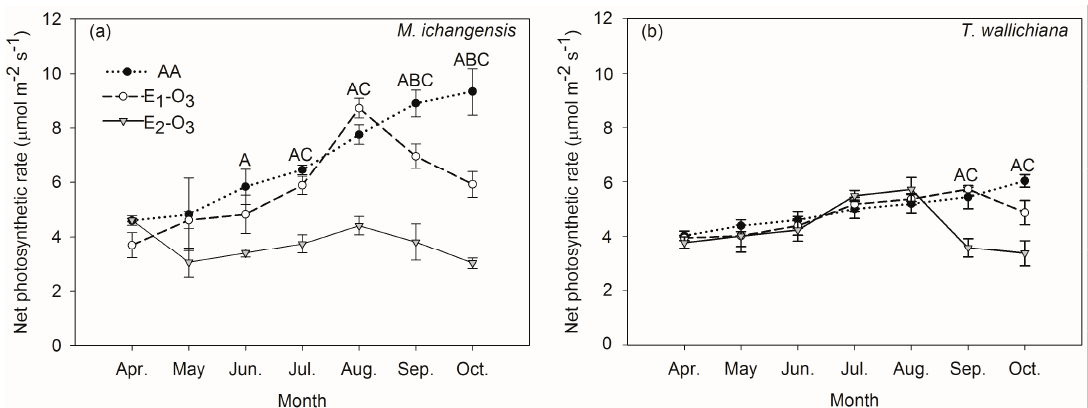
Figure 1. Variations in the net photosynthetic rate (Pn) of Machilus ichangensis Rehd. et Wils. ( M. ichangensis ) ( a ) and Taxus wallichiana Zucc. var. chinensis (Pilg.) Florin ( T. wallichiana ) ( b ) under the different O 3 fumigation treatments . Bars indicate standard error of the mean ( n = 3). The capital letter “A” indicates a significant difference between the ambient air (AA) treatment and the elevated O 3 treatments 2 (E 2 -O 3 ), the capital letter “B” indicates a significant difference between the AA treatment and the elevated O 3 treatments 1 (E 1 -O 3 ), and the capital letter “C” indicates a significant difference between the E 1 -O 3 and the E 2 -O 3 treatments for the same species ( p < 0.05).